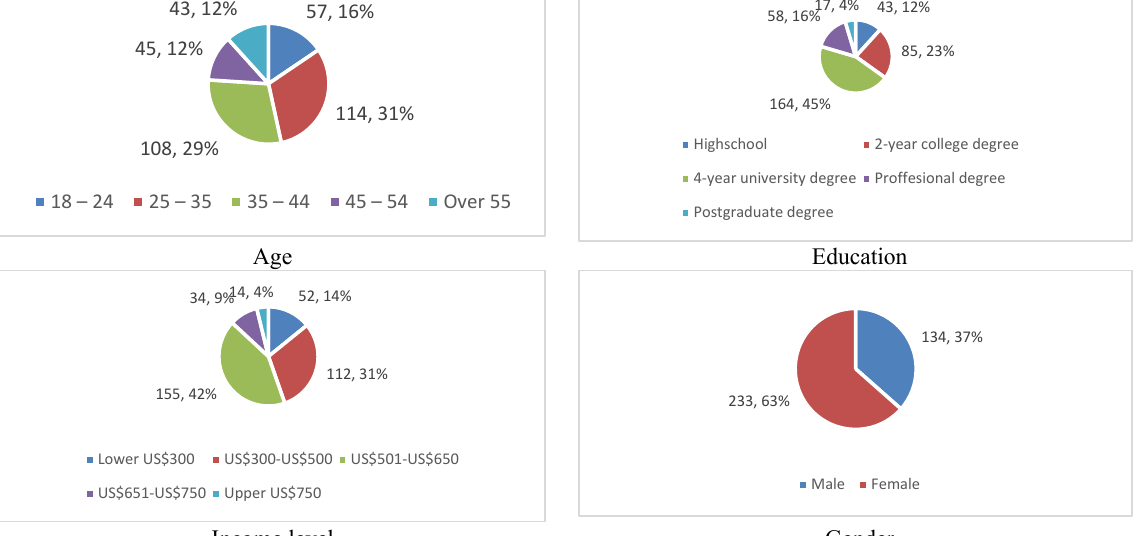
Fig. 2. Demographic characteristics of the respondens (n =